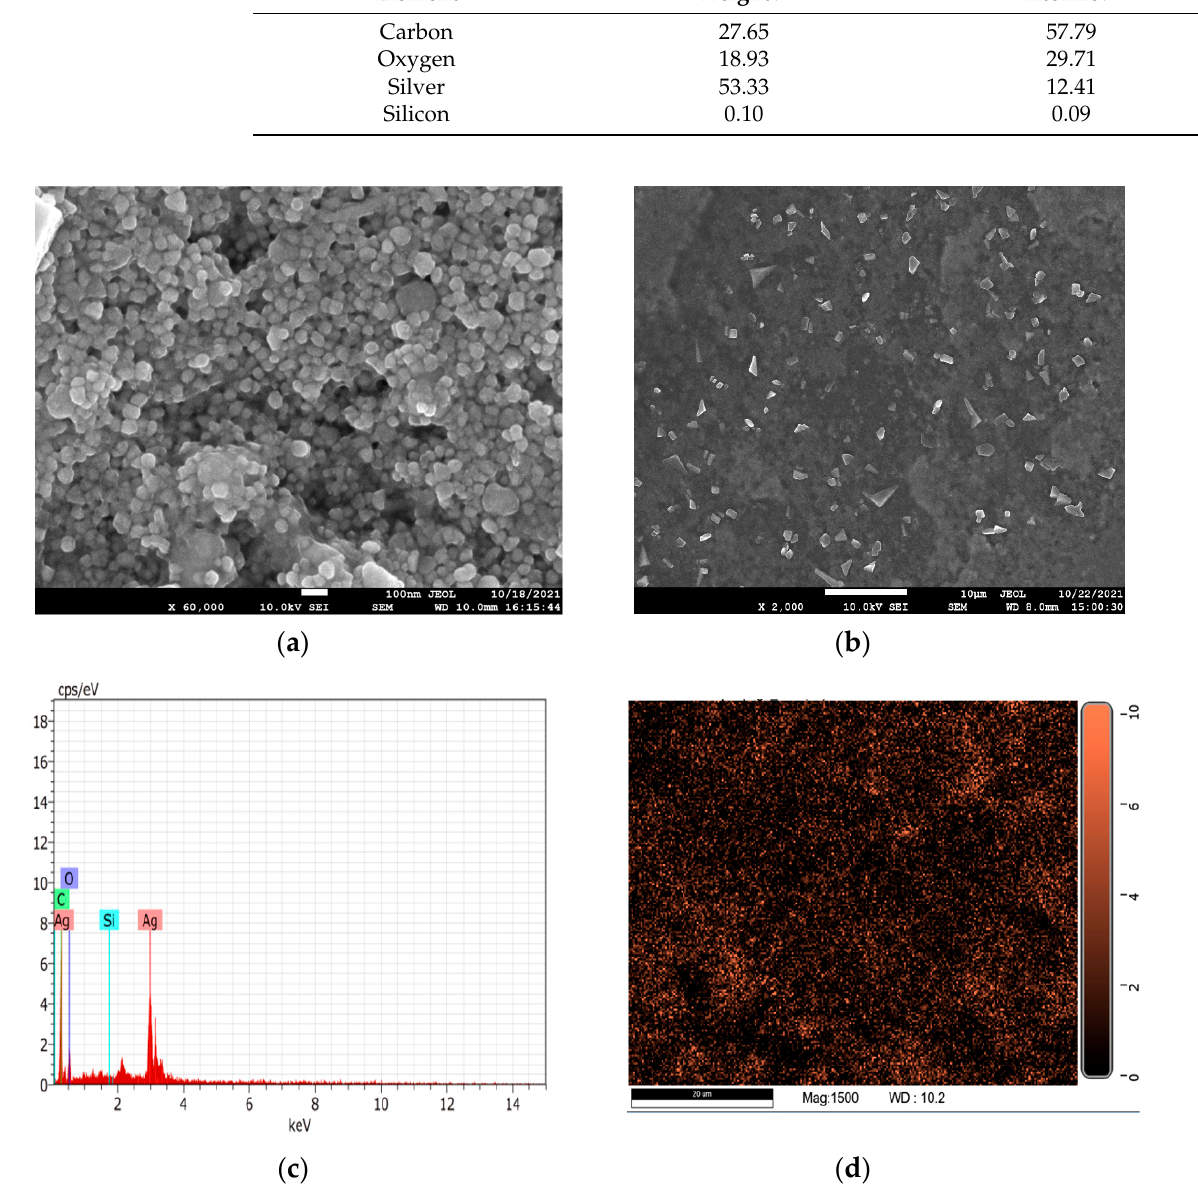
Figure 4. FESEM-EDX micrographic images ( a ) 100 nm scale; ( b ) 10 µm scale; ( c ) elemental mapping of AgNPs; ( d ) red color indicating Ag element. Table 1. EDX analysis parameters of AgNPs.